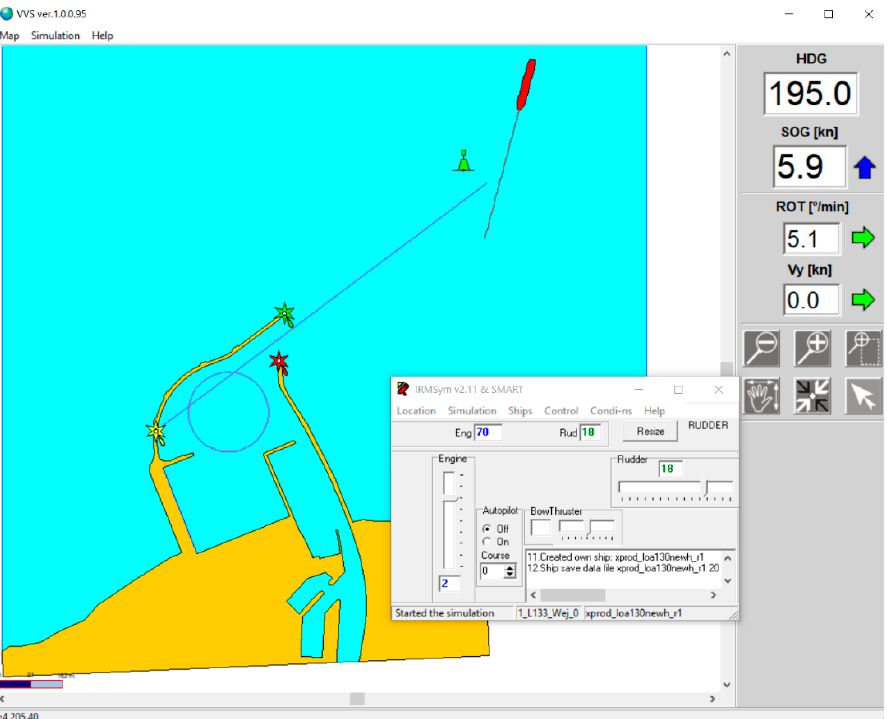
Figure 8. The 2D GUI (Graphical user interface) of the simulation model (with ships movement control panel activated).